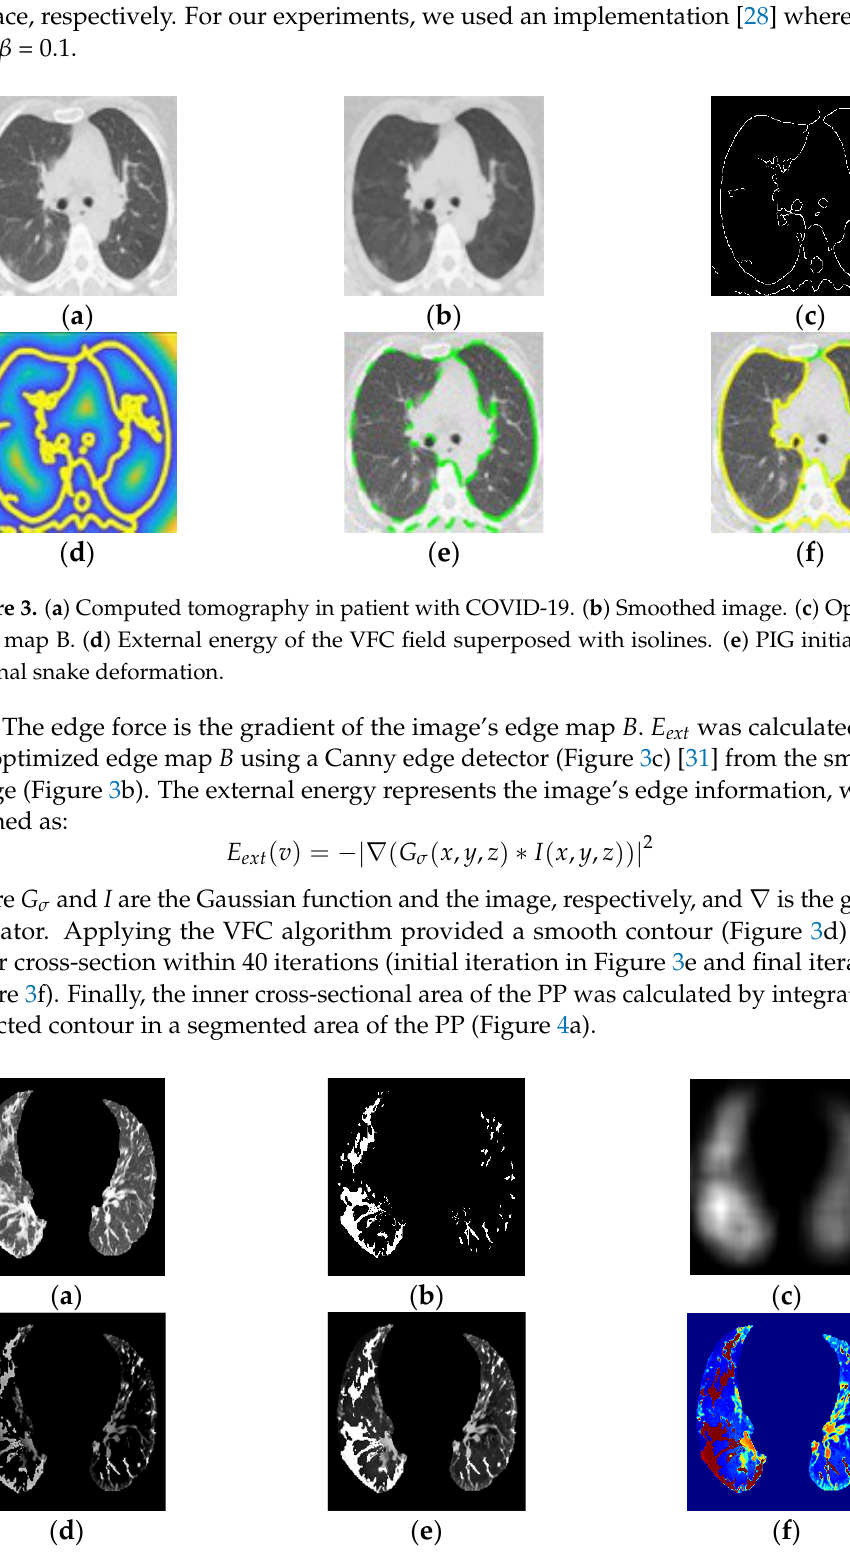
Figure 4. ( a ) PP area image. ( b ) GGO–PI image. ( c ) Base fused image. ( d ) Detail fused image. ( e ) Fused image. ( f ) Transformed RGBjet Fused image.